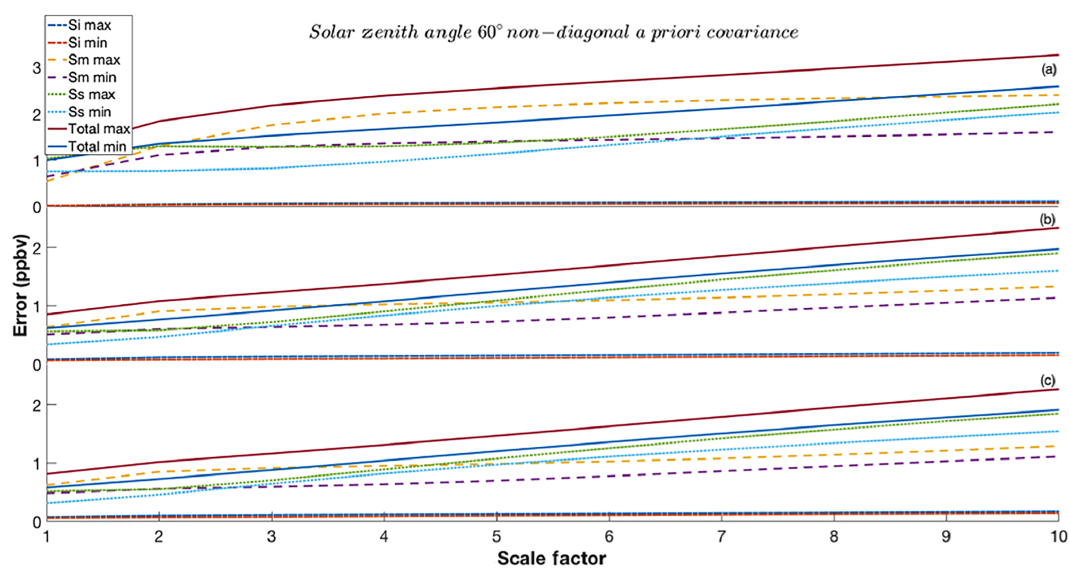
Figure A4. Synthetic total column retrieval errors retrieval for scenarios outlined in Table 3, based on Eqs. (8), (9), (10) and (16). The maximum and minimum values (based on maximum and minimum SNR) for interference, measurement and smoothing error are shown, in addition to the total error: panel (a) indicates scenario 3, panel (b) indicates scenario 6 and panel (c) indicates scenario